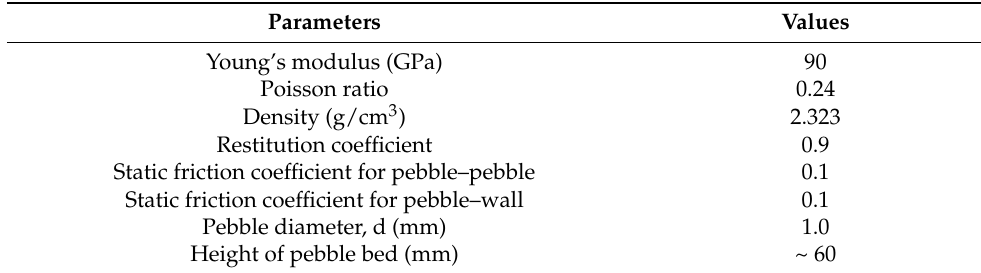
Table 1. Parameters of pebbles used in DEM simulation.